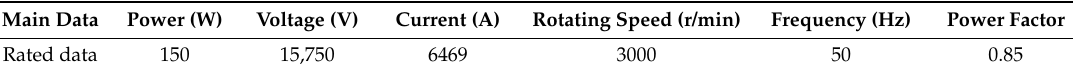
Figure 1. The photo of a broken bar of the 150 MW turbine generator. Table 1. Generator basic data.